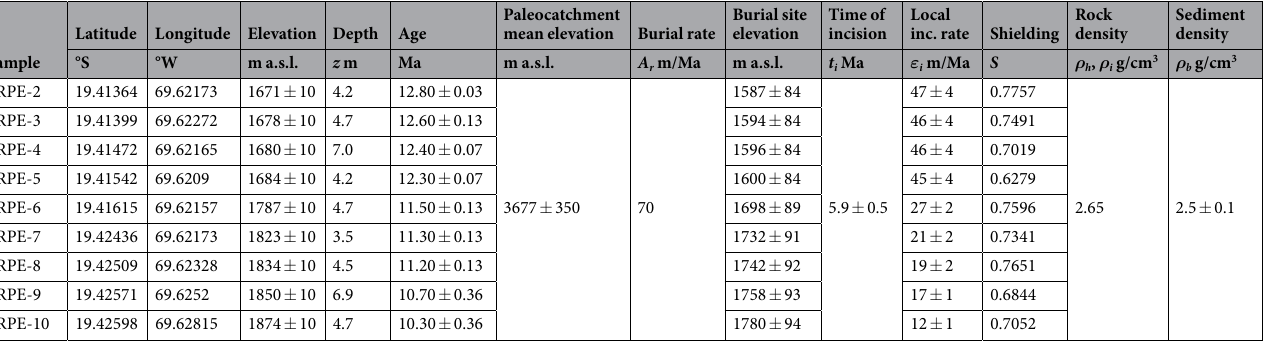
Table 3. List of constraints used in the calculations described